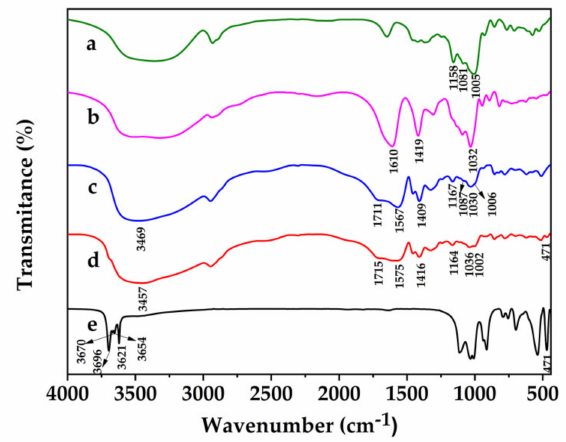
Figure 1. FT-IR spectra of ( a ) starch (ST), ( b ) sodium alginate (SA), ( c ) superabsorbent polymer (SAP), ( d ) superabsorbent composite (SAPC) (4 wt. % KL) and ( e ) kaolin